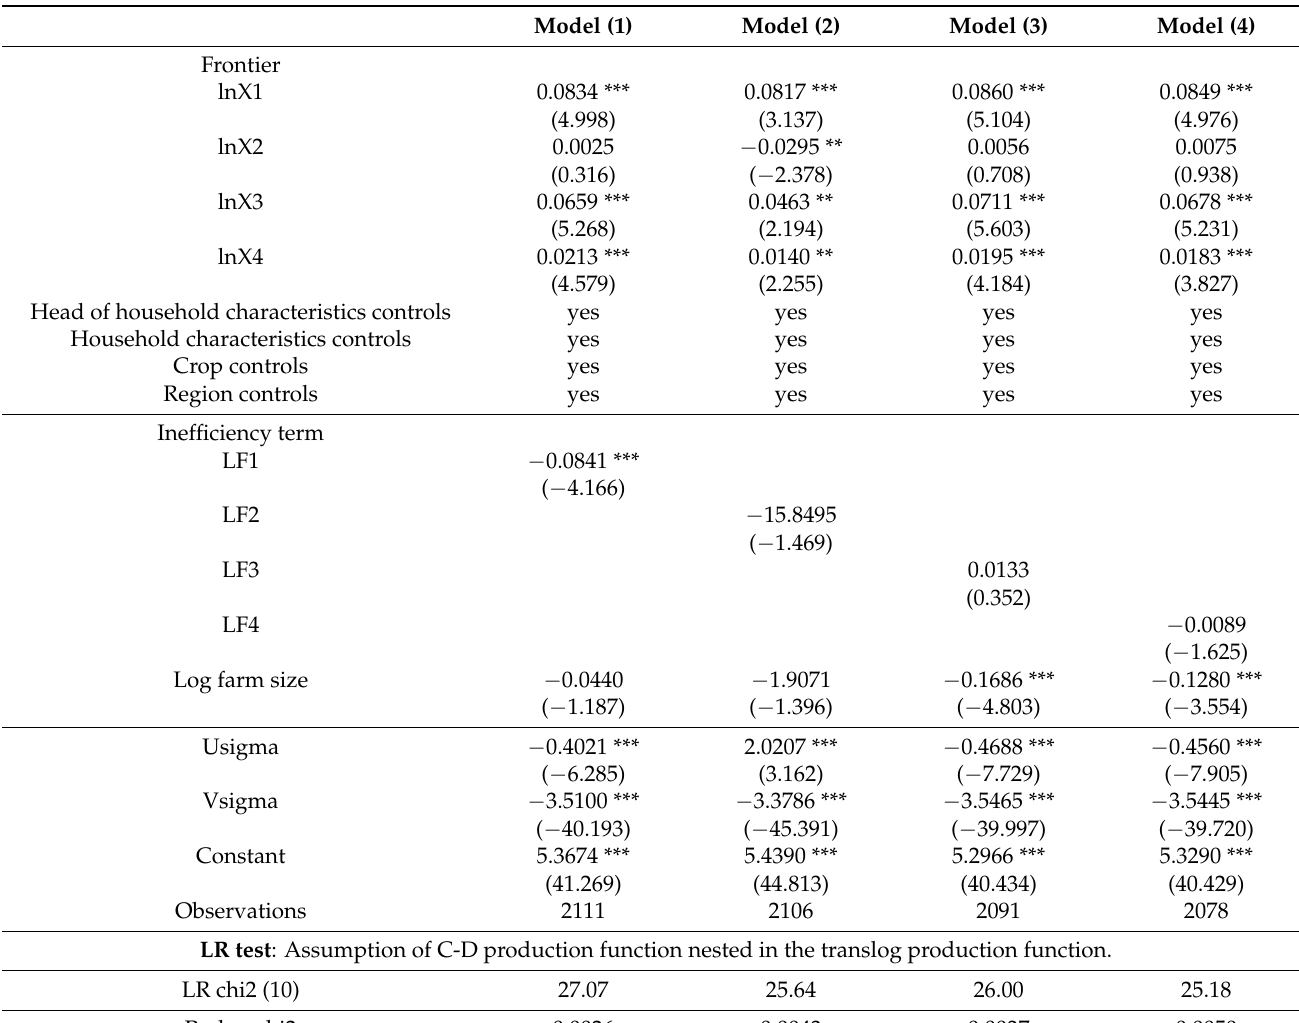
Table A1. Analysis of the effect of LF on technical inefficiency using the C-D production function.